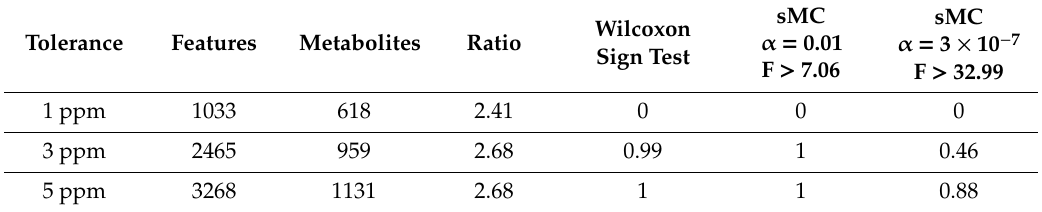
Table 3. Mummichog annotation results and vitamin B3 pathway permutation results.